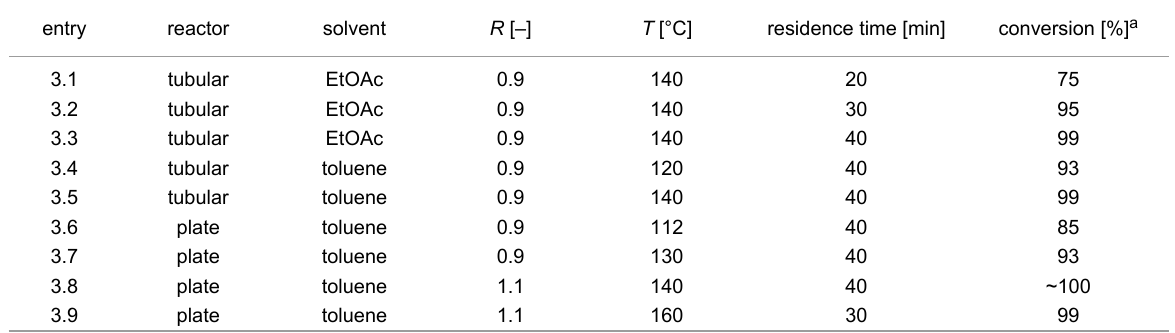
Table 3: Solvents, reaction conditions and results for the continuous-flow reaction of myrcene ( 1 ) with acrylic acid ( 2b ) in a tubular flow reactor (reactor volume: 20 mL) and a plate flow reactor (reactor volume: 105 mL); all entries were reacted with a myrcene to dienophile ratio, R , of 0.9, and c MYR,0 of 2.8